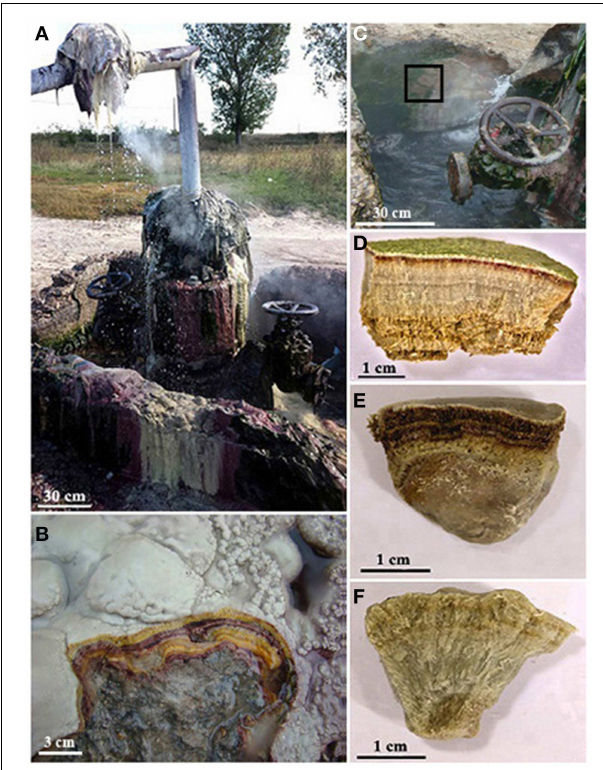
FIGURE 1 | (A) General view of the drilling from Ciocaia; (B) Layered fine strata forming mammillary coatings at 49 ◦ C, seen in fresh break; (C) The small pool formed where the hot water comes out; the rectangle marks the 32 ◦ C sampling area, near the exit of thermal water, but not in direct contact. (D) Detailed view of 32 ◦ C mineral deposit. (E) Detailed view of 49 ◦ C mineral deposit. (F) Detailed view of 65 ◦ C mineral deposit.